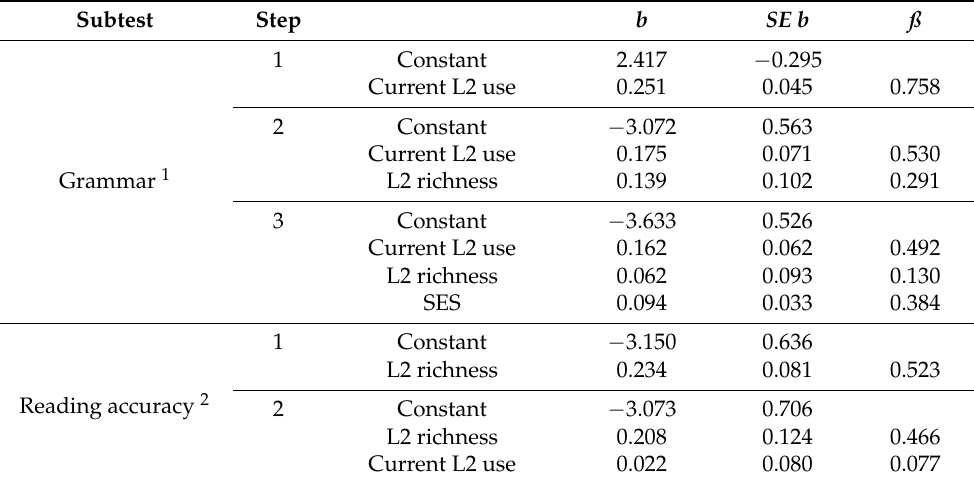
Table 2. Summary of hierarchical regression analyses for age/input variables predicting performance on BUEGA subtests grammar and reading